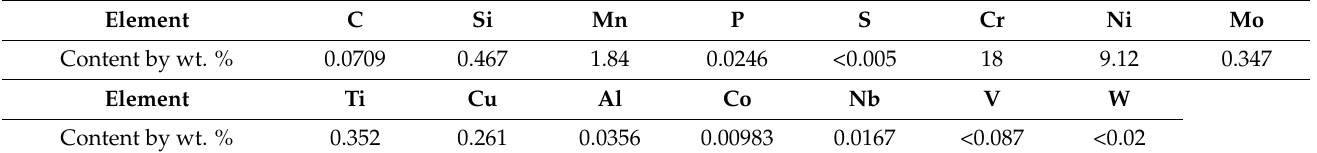
Table 6. Chemical composition of the samples made of X6CrNiTi18-10 steel (according to